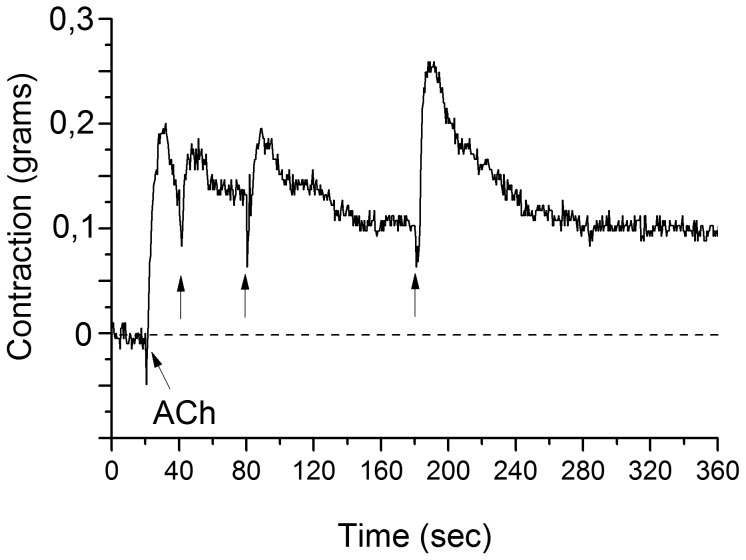
Application of 10−4 M ACh evoked long lasting contraction.Consecutive agonist application (arrows) did not show desensitization of the M3 muscle. The preparation was continuously perfused with physiological saline at a rate of approximately 1 ml/min. The values on the Y axis represent the force of contractions expressed in grams.